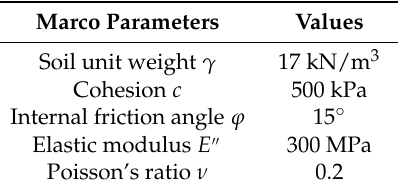
Table 3. The macro parameters of the